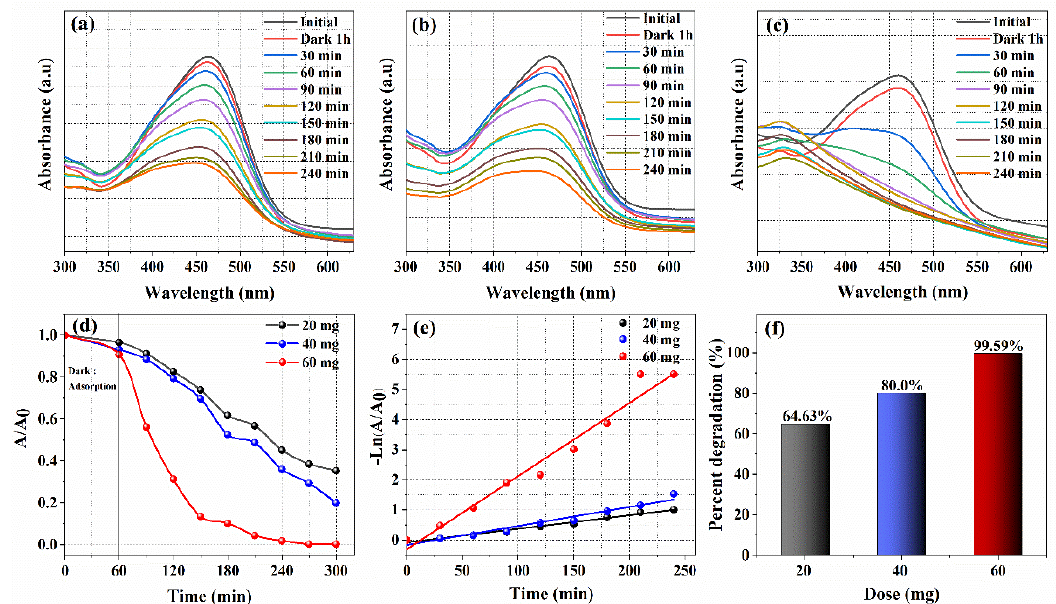
Figure 7. Dose study of photocatalytic PAN_Coa NFs membrane. Spectrophotometer spectra at different time intervals and photocatalytic doses ( a ) 20 mg, ( b ) 40 mg and ( c ) 60 mg, ( d , f ) degradation and ( e ) kinetics The concentration of methyl orange was constant (10 ppm).